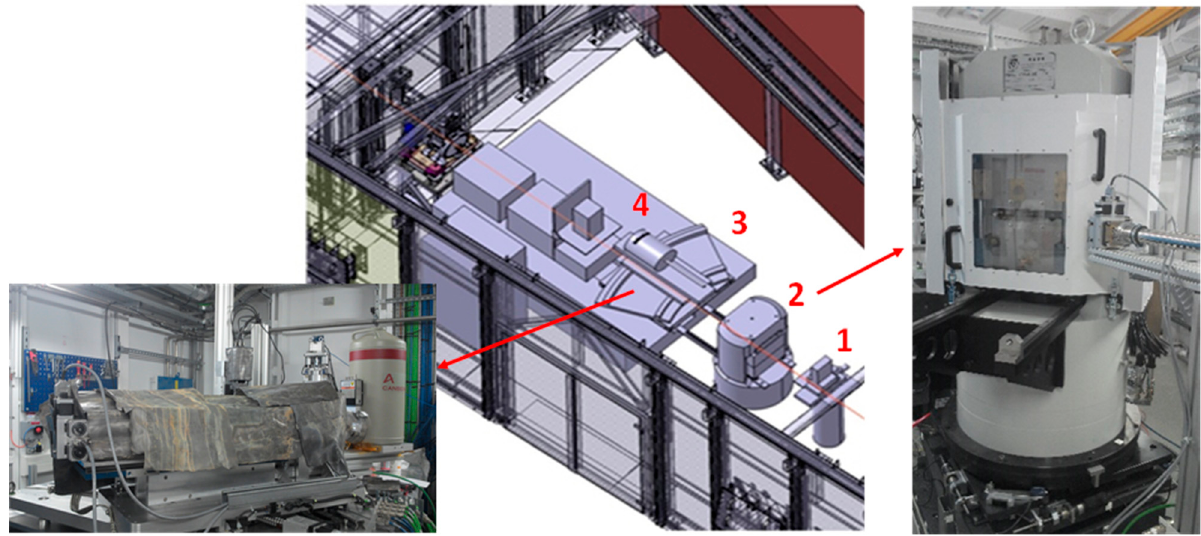
Figure 3. Optics hutch of PSICHE beamline at SOLEIL, a synchrotron X-ray diffraction station (EDX) associated with a multi-anvil press. (1) Input collimating slits. (2) Multi-anvil press. (3) CEASAR system with (4) solid-state germanium detector.